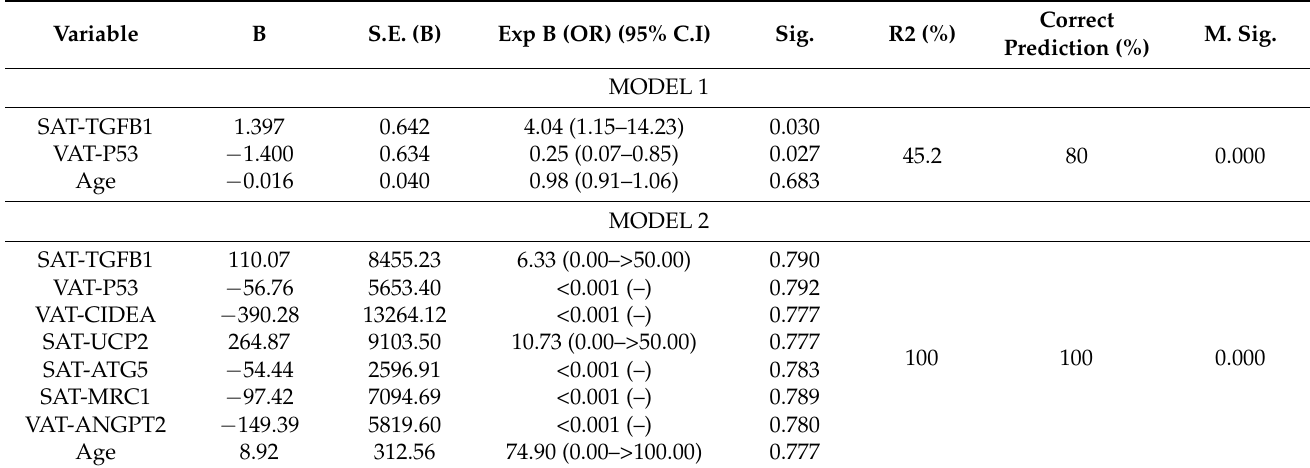
Table 4. Multinomial logistic regression of VAT and SAT gene expression associated with